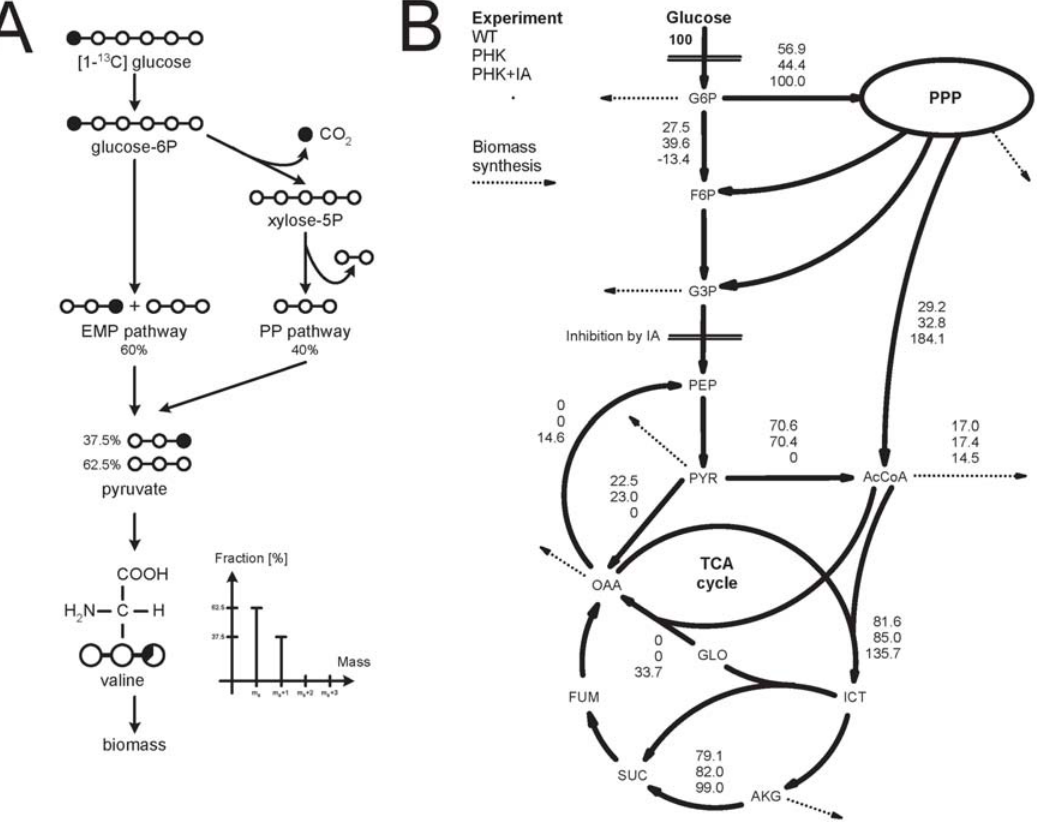
Figure 1. A) Principles of metabolic network analysis with [1- 13 C] glucose. The 13 C labelling pattern of pyruvate is dependent on the active metabolic pathways. For instance, pyruvate formed in the EMP pathway contains 13 C carbon in position 3, while activity of the PP pathway results in loss of labelled carbon. Pyruvate is the precursor of valine, which is incorporated into biomass. Based on the labelling pattern of valine and other proteinogenic amino acids the fluxes in the central carbon metabolism can be resolved. B) Major metabolic fluxes of the A. nidulans strains investigated. The two strains, A4 (WT) and AR1 phk GP74 (PHK). IA indicates the presence of iodo acetate in the cultivation medium. All fluxes are relative to a glucose uptake rate of 100 moles (arbitrary